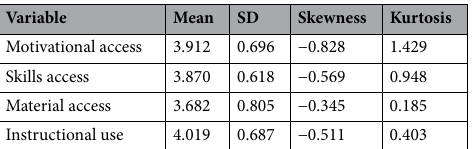
Table 1. Mean, standard deviation (SD), skewness, and kurtosis.